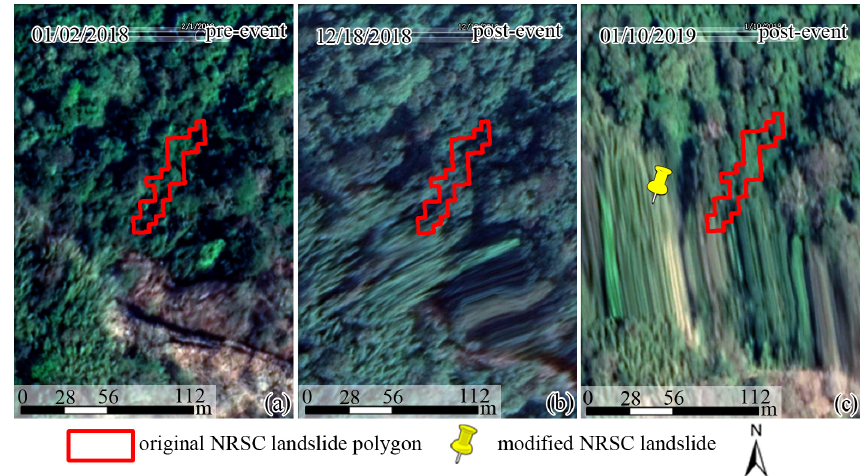
Figure 8. Example of distorted images in Google Earth in which it was not possible to check the original NRSC landslide polygons. They were converted into points and digitized on the top of the scarps based on Resourcesat-2 LISS-IV images: (a) pre-landslide image, (b) post- landslide image, and (c) creation of a new inventory using points based on post-landslide image. Basemap data © Google Earth 2019.